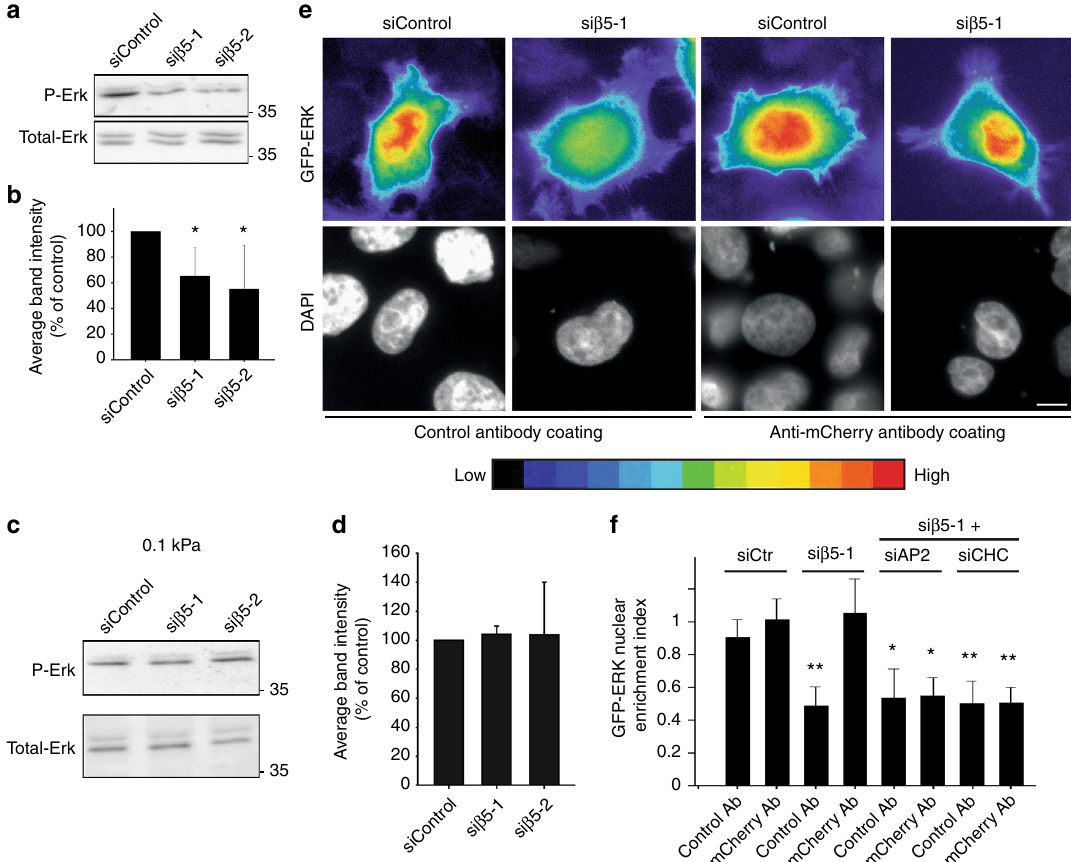
Fig. 4 Clathrin-coated plaques regulate stiffness-dependent Erk signaling. a Western-blot analysis of phospho-Erk (P-Erk) levels in HeLa cells growing on collagen-coated glass and treated with control or β 5-speci fi c siRNAs as indicated (representative image of four independent experiments). Total-Erk was used as a loading control. b Densitometry analysis of bands obtained in western-blots as in a . Results are expressed as mean ± SD from four independent experiments (* P < 0.05, one-way analysis of variance — ANOVA). c Western-blot analysis of phospho-Erk (P-Erk) levels in HeLa cells growing on collagen- coated, 0.1 kPa polyacrylamide gels and treated with control or integrin β 5-speci fi c siRNAs, as indicated. Total-Erk was used as a loading control (representative image of three independent experiments) d Densitometry analysis of bands obtained in western-blots as in c . Results are expressed as mean ± SD from three independent experiments. e GFP-Erk-expressing HeLa cells treated or not with a β 5-speci fi c siRNA and transfected or not with TfR- mCherry, as indicated, were seeded on anti-mCherry antibodies-coated glass and imaged 24 h later. Scale bar: 10 µ m. A color-coded scale for low and high signal intensity is shown. f Quanti fi cation of GFP-Erk nuclear enrichment index in cells as in e and cultured on control antibody- or anti-mCherry antibody- coated glass, as indicated, and treated or not with indicated siRNAs. Results are expressed as mean ± SD (* P < 0.01, ** P < 0.001, ANOVA. ControlAb-siCtr: 114 cells from n = 5 independent experiments; mChAb-SiCtrl: 119 cells from n = 5 independent experiments; ControAb-si β 5-1: 146 cells from n = 5 independent experiments; mChAb-Si β 5-1: 120 cells from n = 5 independent experiments; ControlAb-si β 5-1 + siAP-2: 69 cells from n = 3